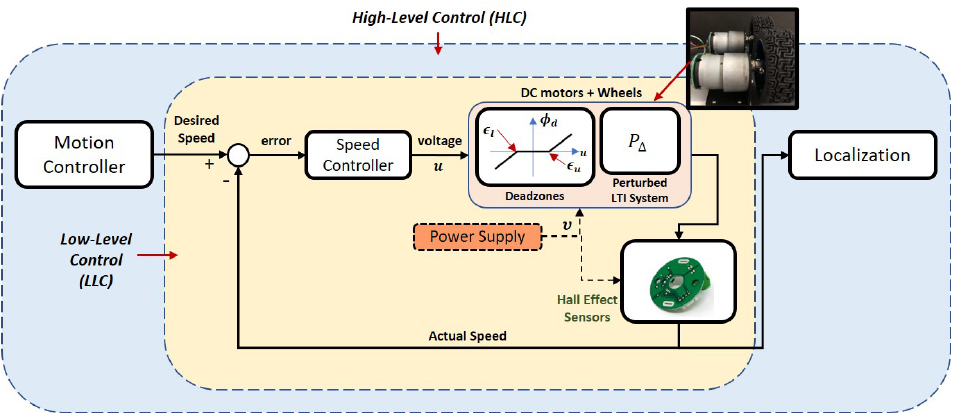
Figure 1. Overview of the motion control system